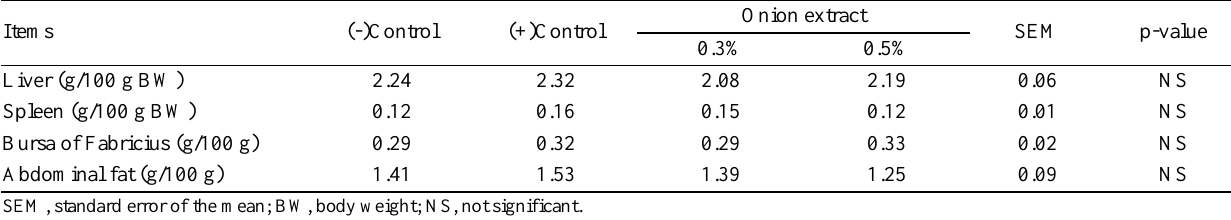
Table 3. Dietary effects of onion extract on carcass characteristics of White mini broilers 1